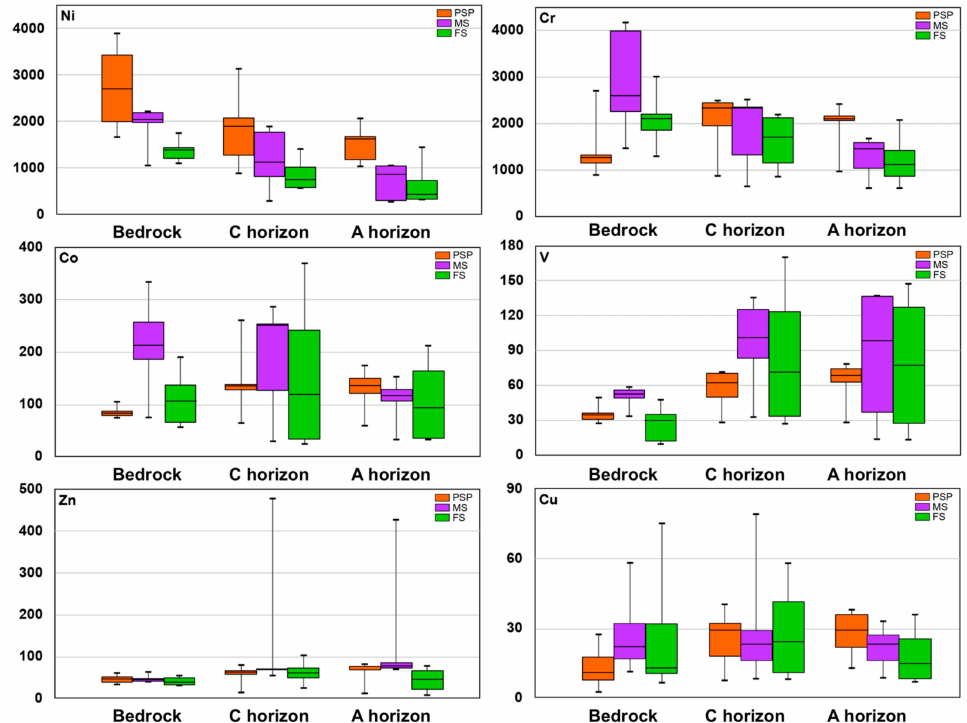
Figure 6. Box plots showing statistical parameters for contents (in ppm) of Ni, Cr, Co, V, Zn, and Cu in soils on PSP, MS, and FS bedrocks. Vertical lines show the range in contents, the boxes are bounded by the 1st and 3rd quartile whereas the horizontal line inside the box represents the median value. Statistical parameters are based on 30 analyses. Bedrock data from